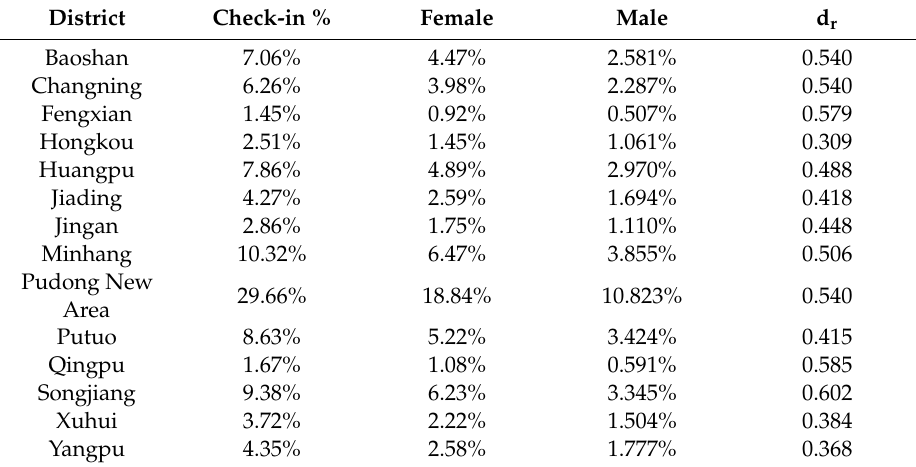
Table 8. Gender di ff erences in districts of Shanghai.